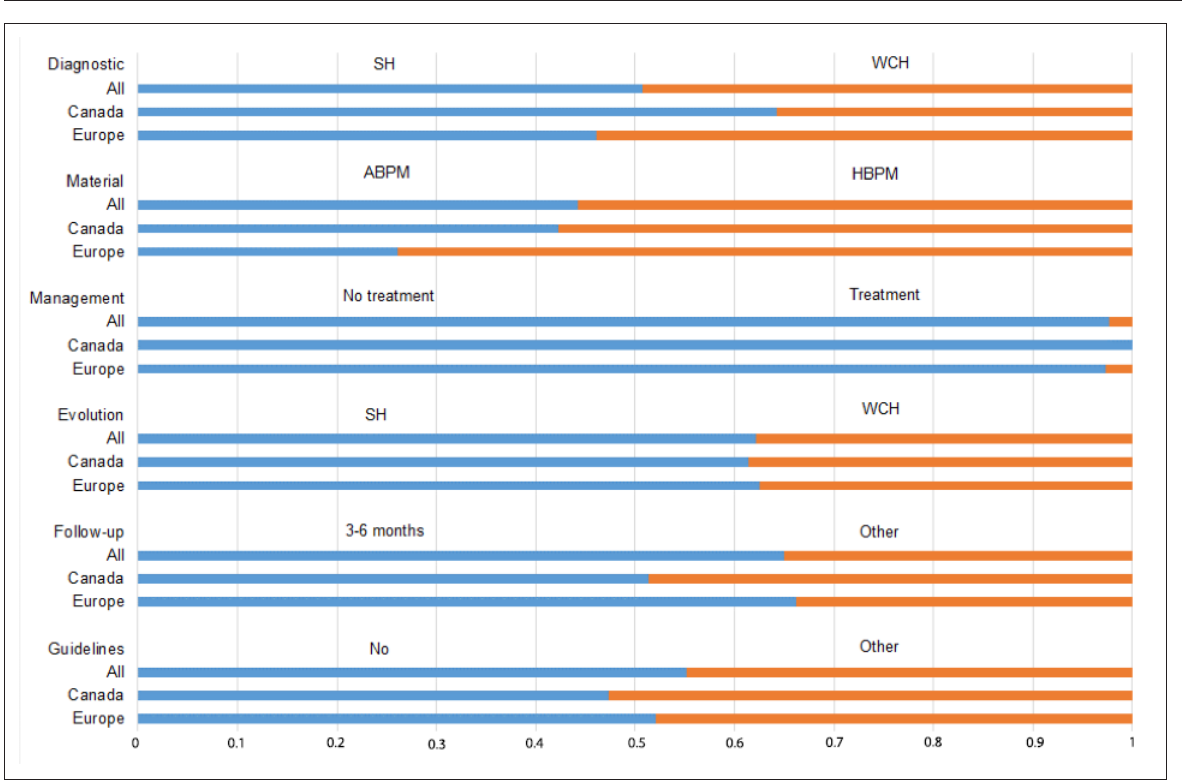
Figure 1 Comparisons between Canadian and European GPs concerning clinical vignette responses ABPM = ambulatory blood pressure monitoring. HBPM = home blood pressure monitoring. SH = sustained (essential) hypertension. WCH = white-coat